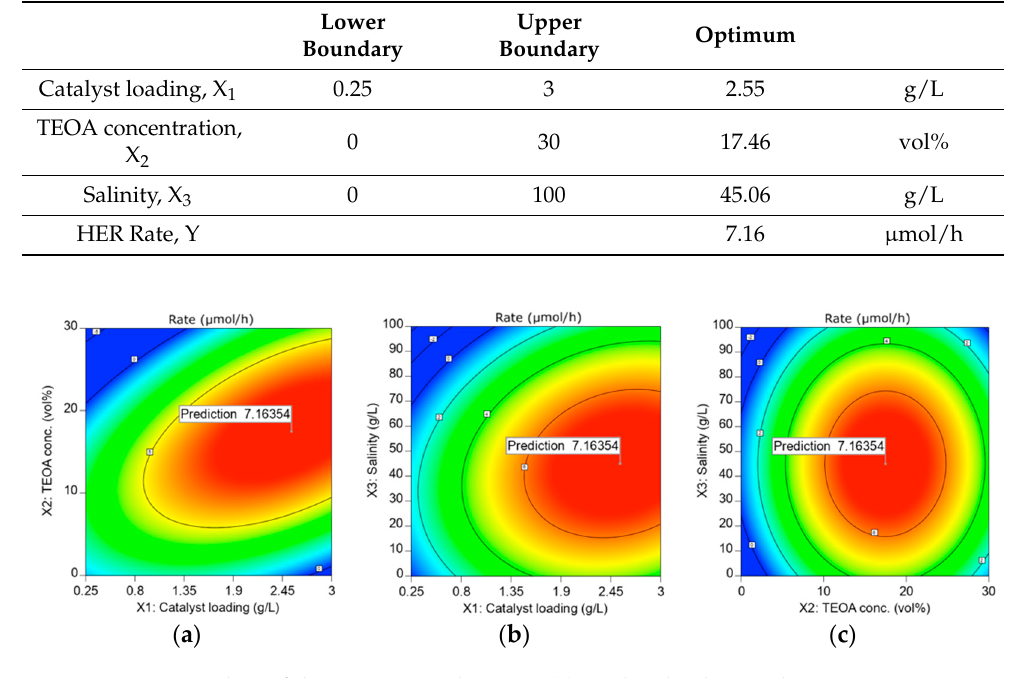
Figure 5. Contour plots of the interactions between ( a ) catalyst loading and TEOA concentration; ( b ) catalyst loading and salinity; ( c ) TEOA concentration and salinity at a designated range based on the HER rate.